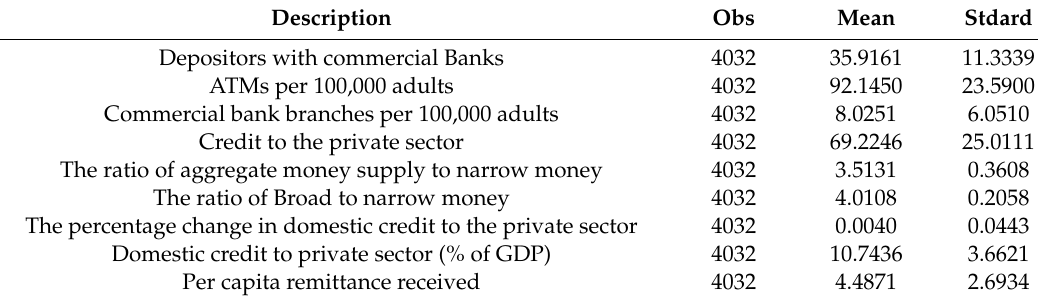
Table 1. Summary of descriptive